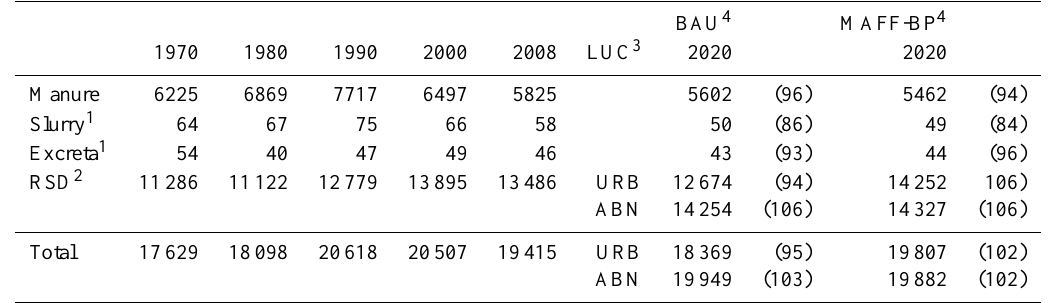
Table 1. Amount of organic carbon from different sources applied to soils in agricultural area of Japan, employed in simulation (unit: GgCyr − 1 ) .